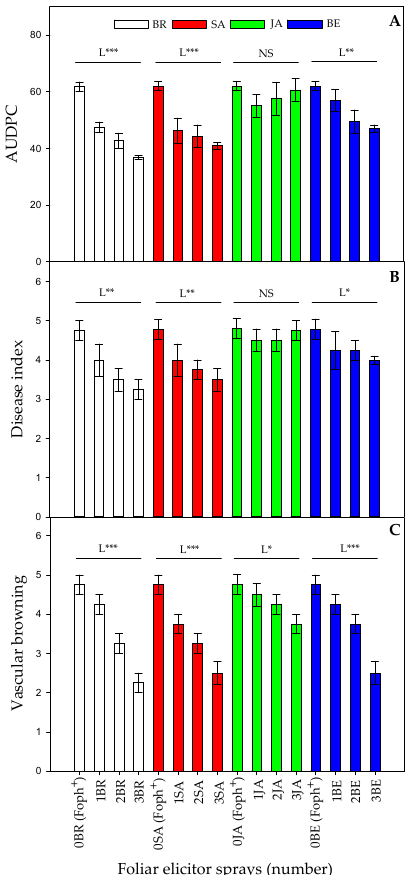
Figure 1. Effect of the interaction between synthetic elicitors (Salicylic acid (SA), jasmonic acid (JA), Brassinosteroids (BR), or botanical extracts (BE)) and the sprays number (0, 1, 2 and 3 applications) on area under the disease progress curve (AUDPC) ( A ), vascular wilt index ( B ) and vascular browning ( C ) in Fusarium oxysporum f. sp. physali (Foph + ) infected cape gooseberry ( Physalis peruviana L.) plants at 50 DAI. Each point represents the average of ten plants ( n = 10). NS, not significant at α = 0.05. *, ** and *** significant at P ≤ 0.05, 0.01 and 0.001, respectively. L = linear.